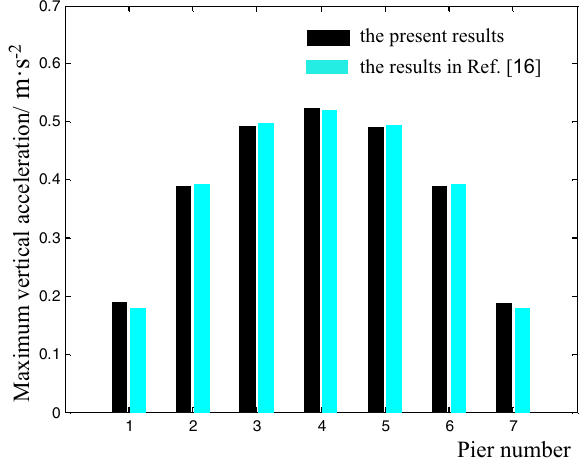
Fig. 4 Influence of wave frequency on the vertical force for the 4th pontoon ( 𝛽 = 22.5 ◦ )